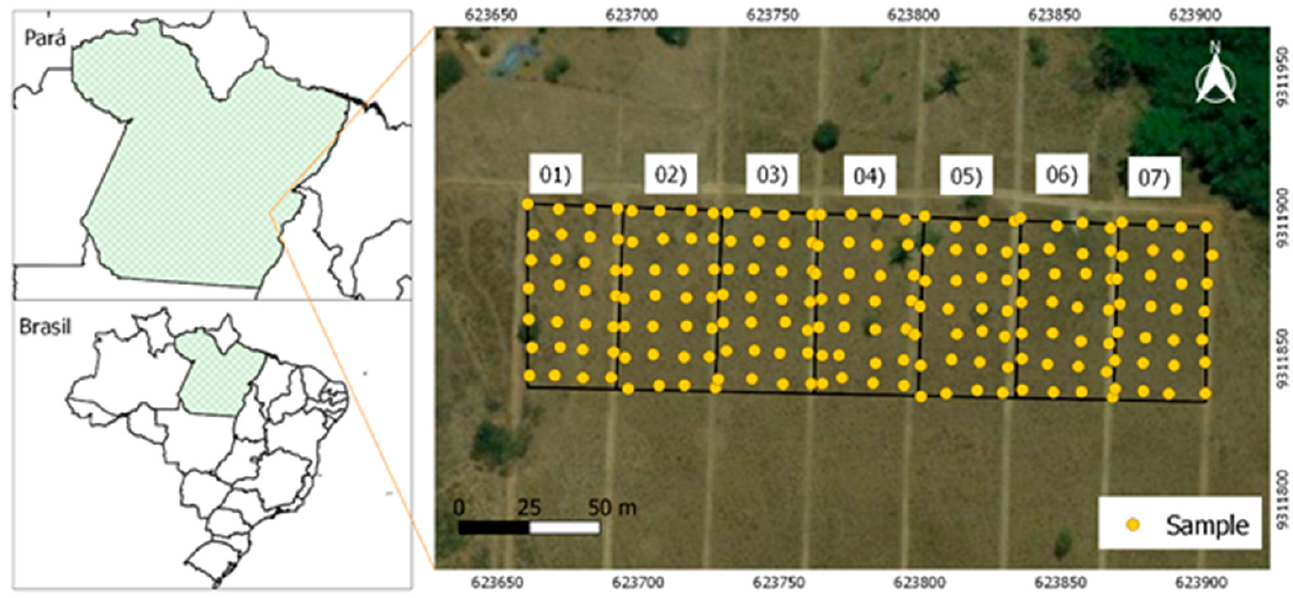
Figure 1. Location of the study area and experimental divisions.